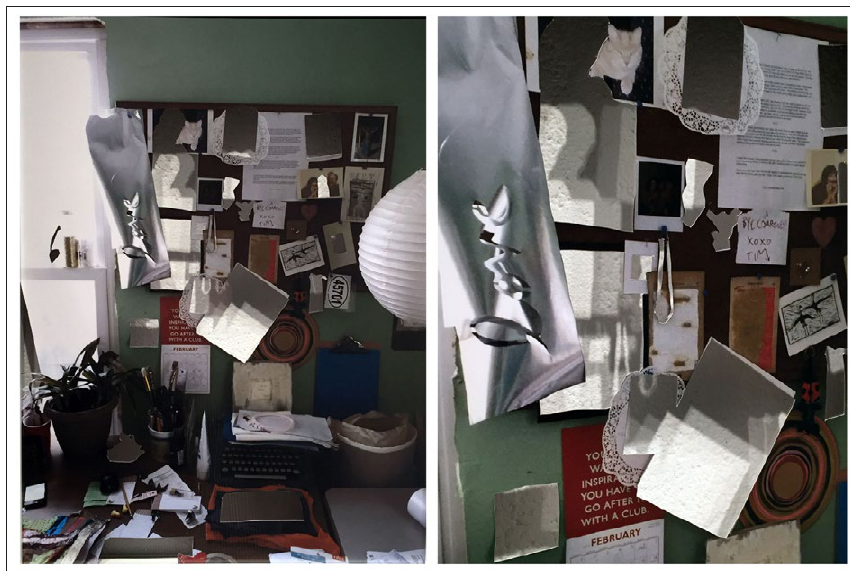
Figure 21: Courtney Kessel, Without Chloé Series (1–6), Hand cut digital photograph, 18 × 24 inches,